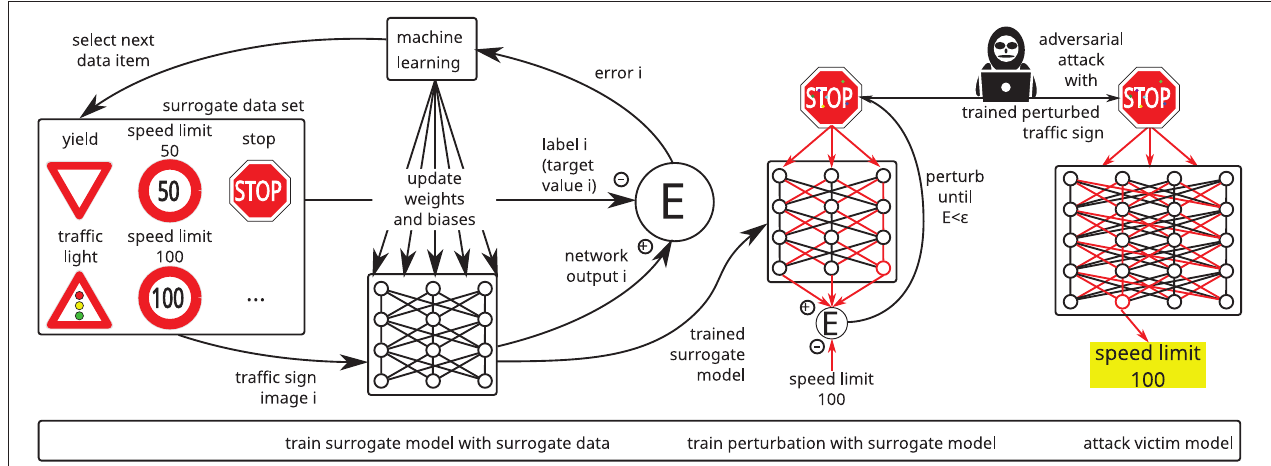
FIGURE 5 | Adversarial attacks may be conducted without white-box access to the victim model: First, a surrogate model is trained using a surrogate data set. Labels for this data set might optionally be obtained via queries to the victim model. Subsequently, the trained surrogate model is used to generate adversarial input examples. In many cases, these adversarial examples may then be used successfully for attacking the victim model.